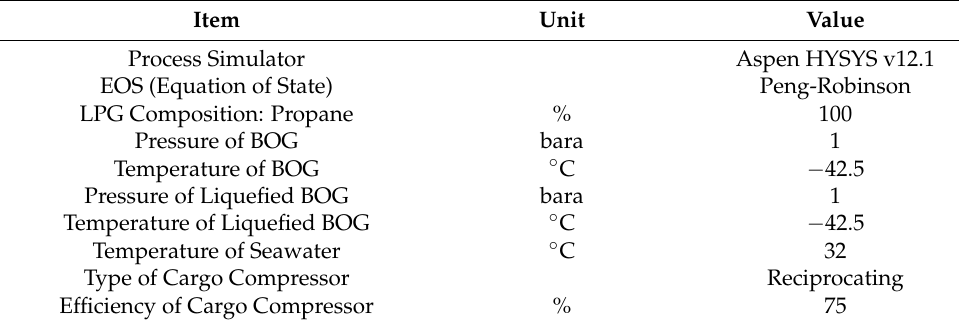
Table 2. Values assumed for process